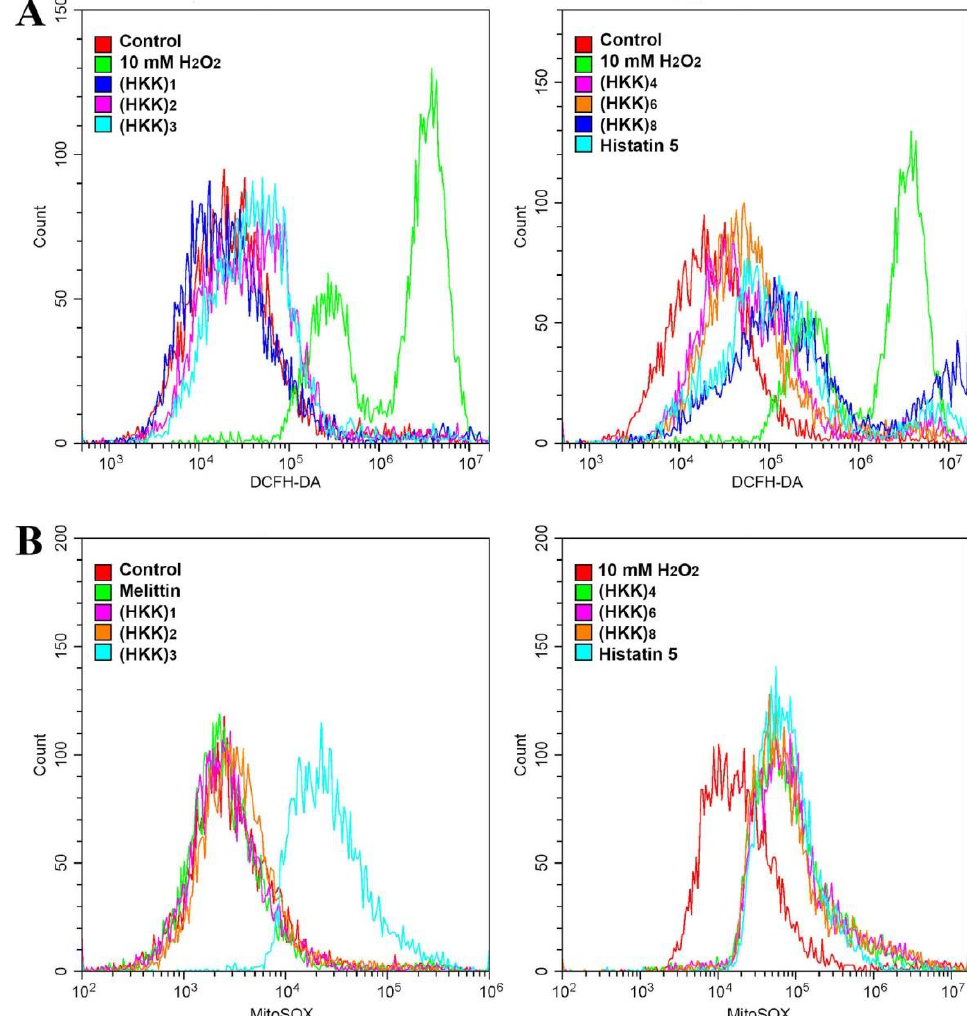
Figure 4. Intracellular ROS ( A ) and mitochondrial superoxide (SOX) generation ( B ) in the presence of peptides in C. albicans cells. ( A ) After incubation of the samples with the indicated peptides at their MICs, or with 10 mM H 2 O 2 for 6 h in C. albicans cells, the cells were stained with 100 µ M DCFH-DA for 20 min and analyzed using flow cytometry; ( B ) After incubation of the samples with the indicated peptides at their MICs for 6 h in fungal cells, MitoSOX Red was added to the cells and flow cytometry analysis was performed.